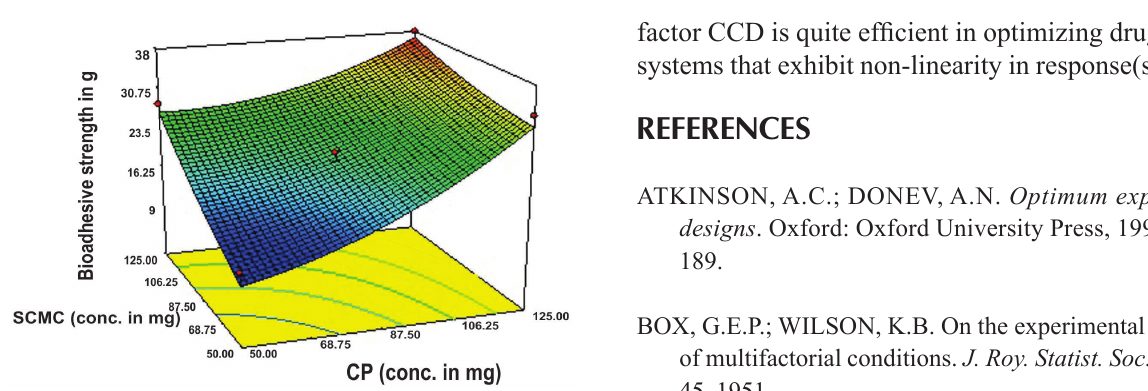
FIGURE 10 - Response surface plot showing the influence of CP and SCMC on the value of bioadhesive strength ( f ) of mucoadhesive tablet formulations of flurbiprofen.